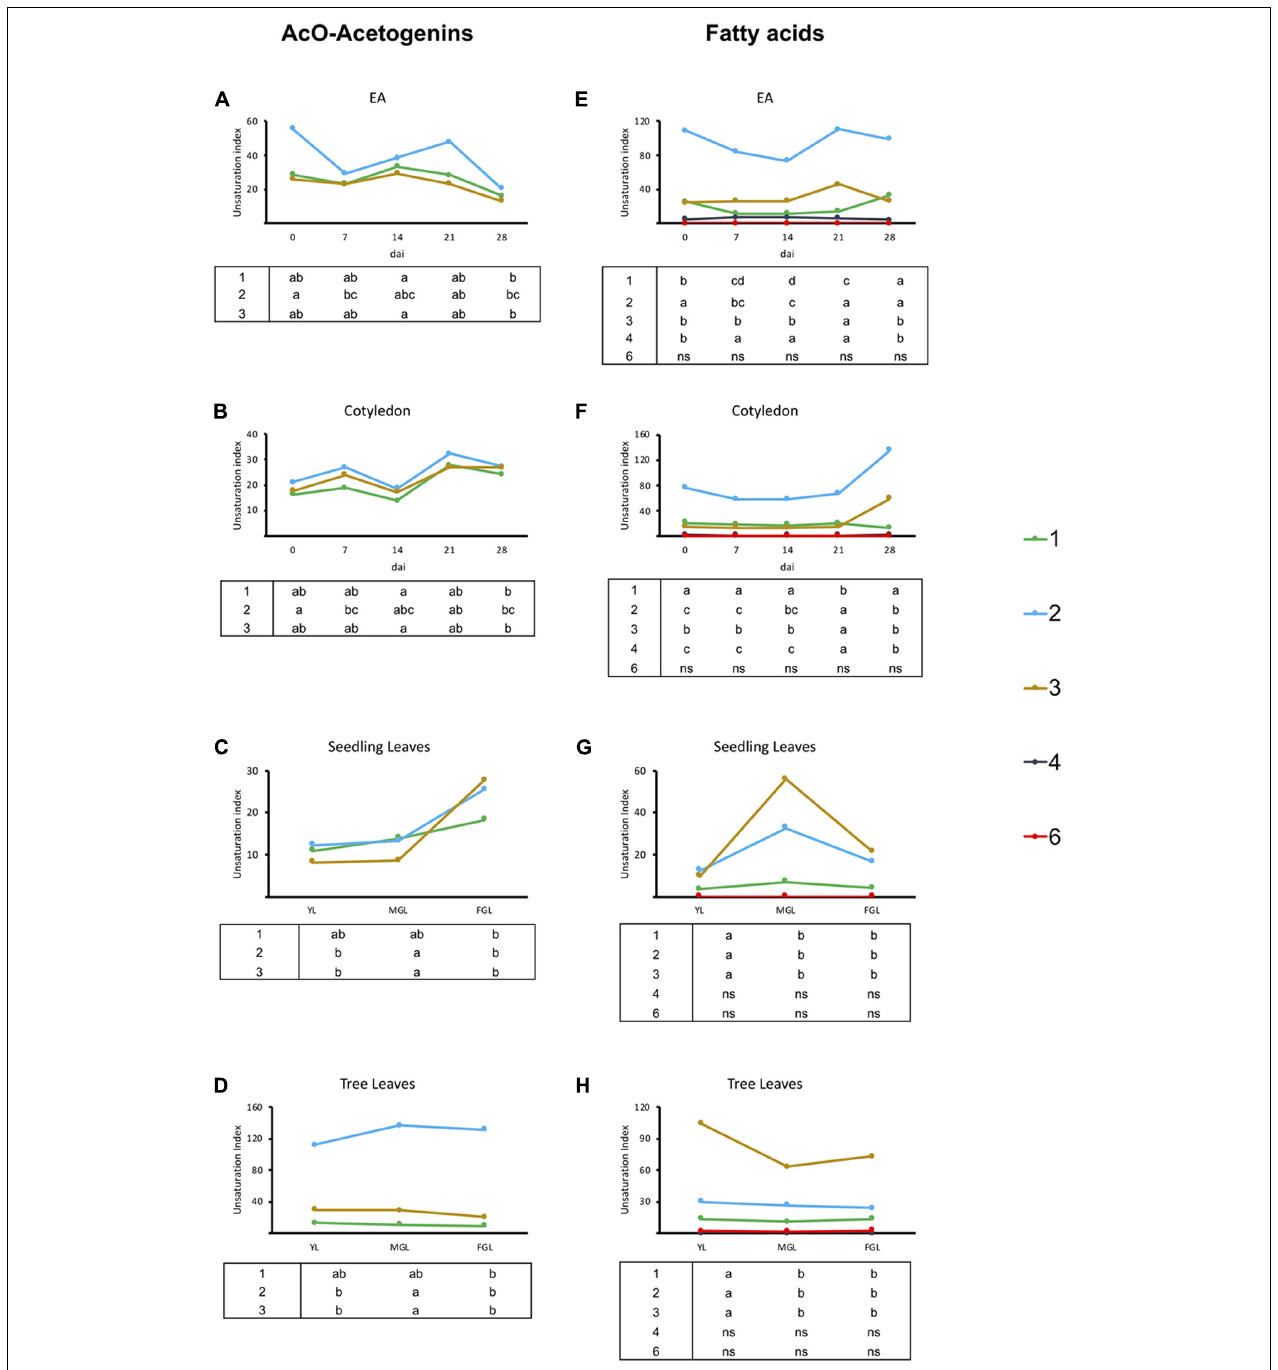
FIGURE 4 | Unsaturation index for acetogenins and FAs in avocado seeds and leaves. (A–D) Unsaturation indices for acetogenin content of EA, COT, SDL, and TRL, respectively. (E–H) Unsaturation indices for FA content of EA, Cotyledon, Seedling leaves, and Tree leaves respectively. Each point represents mean values. The tables below graphics indicate statistical differences among groups for each unsaturation degree. Different letters indicate significant statistical differences between treatments (ANOVA, Fisher LSD, P < 0.05). N = 4 for EA and Cotyledon; n = 3 for leaves. EA embryonic